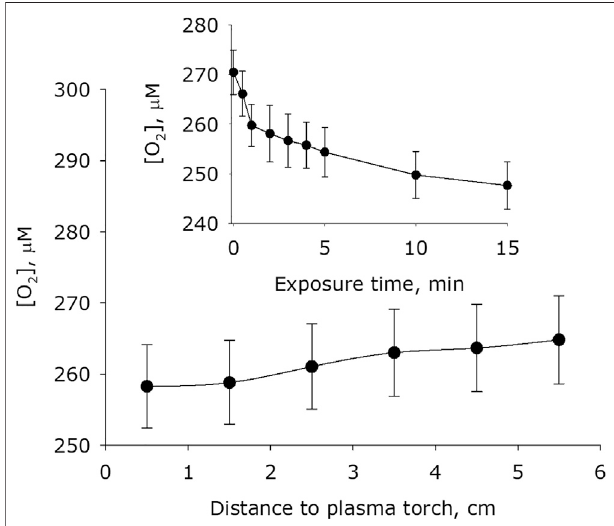
FIGURE 7 | Dependence of the concentration of oxygen dissolved in water on distance from water surface to the plasma jet nozzle at 1 min of plasma exposure. Data are presented as mean standard error for three independent experiments. Inset shows dependence of the concentration of oxygen dissolved in water on the time of plasma exposure at 1.5 cm distance from water surface to the plasma jet nozzle. The data are presented as average values with standard deviation of three experiment repetitions.